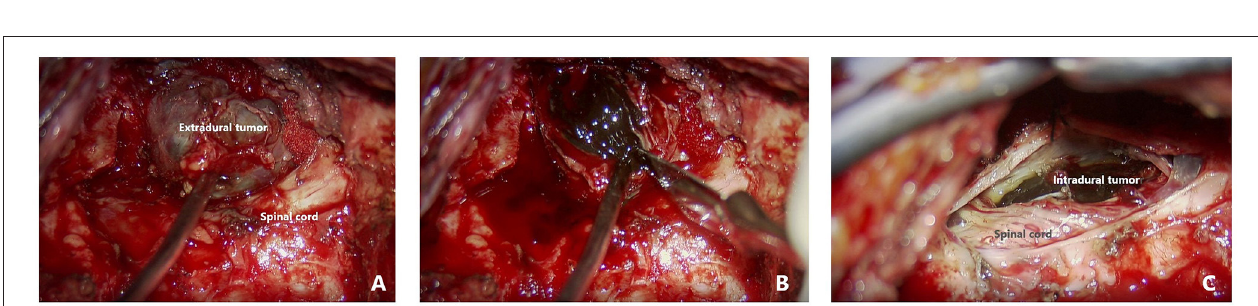
FIGURE 1 | Preoperative cervical MRI prior to the first surgery. (A) Sagittal T1 weighted image showing a hyperintense lesion at C1–C2. The lesion is triangular shaped with a relatively clear margin, causing compression of the cervical spinal cord. (B) Sagittal contrast-enhanced T1 weighted image showing relatively homogenous enhancement. (C) Axial contrast-enhanced T1 weighted image showing the lesion extending from the subdural space, through the neuroforamen, forming a dumbbell-shaped contour. (D) Coronal contrast-enhanced T1 weighted image.